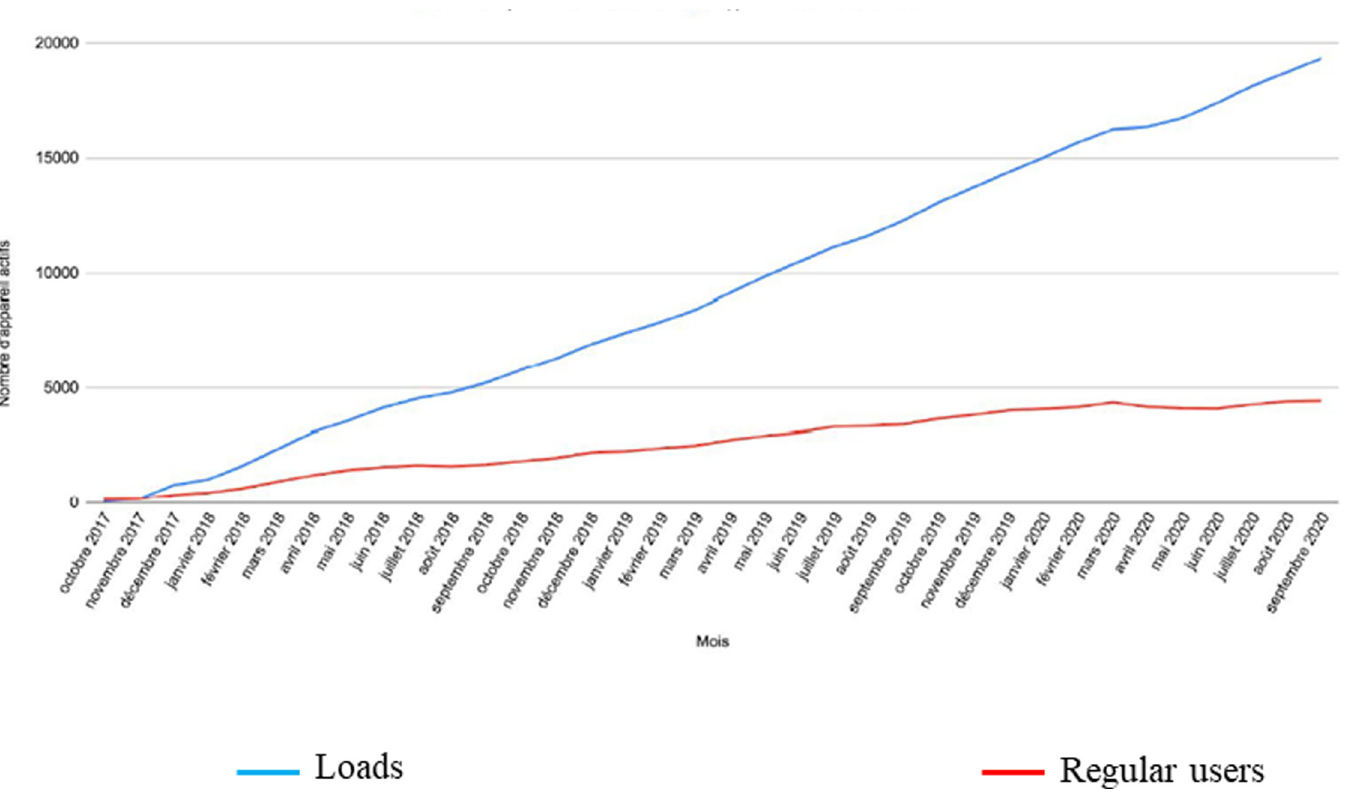
Fig 3. Number of installations and mean number of regular users � from October 2017 to September 2020. � Regular user: individual using the app once a month or more (data from Android + iOS).